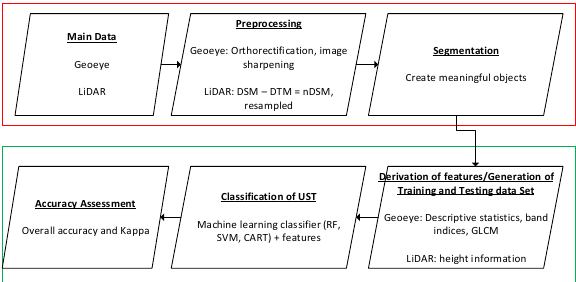
Figure 3. Flow chart, red box is data pre-processing, while green box is classification of